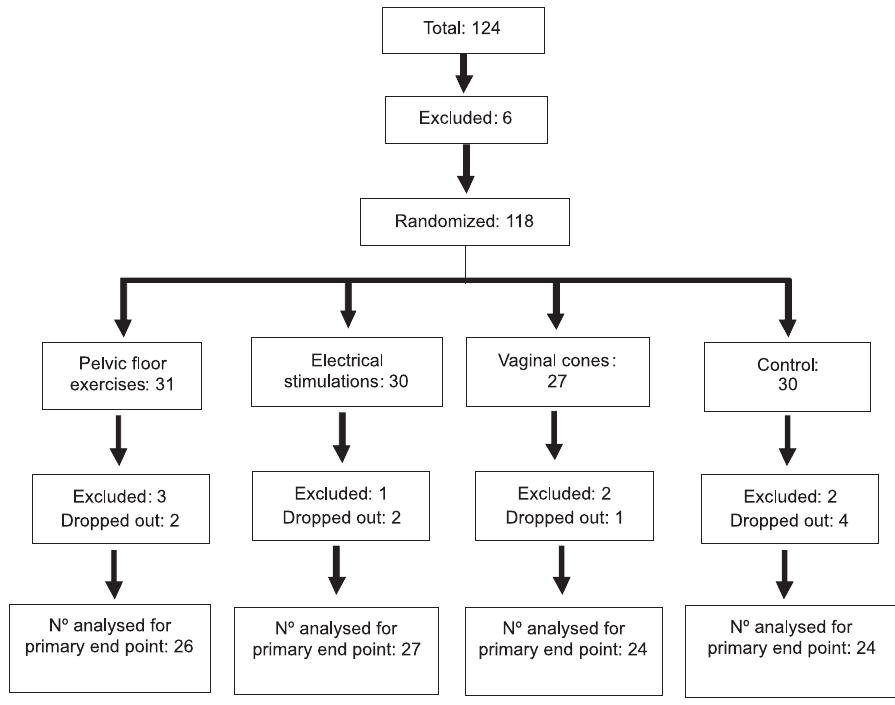
Figure 1 - Flow of participants through trial